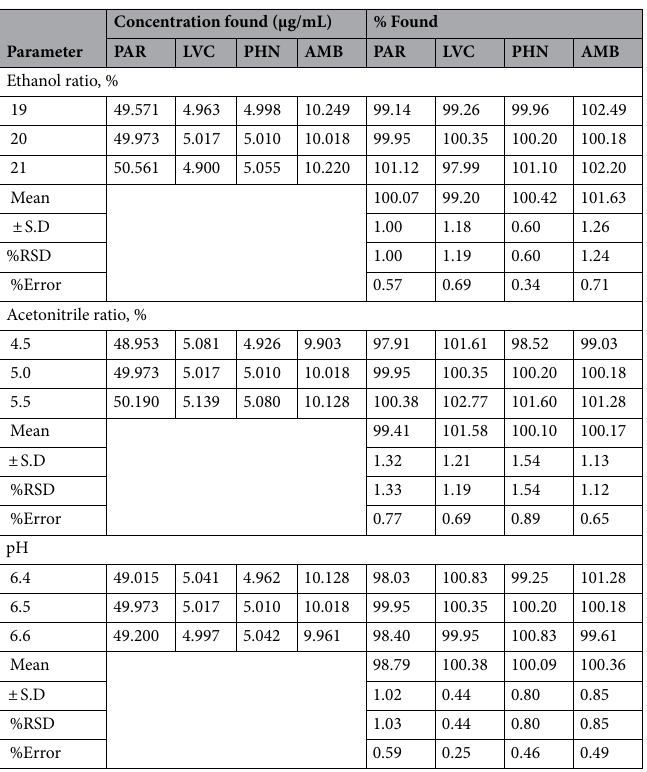
Table 4. Robustness of the suggested technique using (50, 5.0, 5.0 and 10 μg/mL of PAR, LVC, PHN and AMB, respectively).